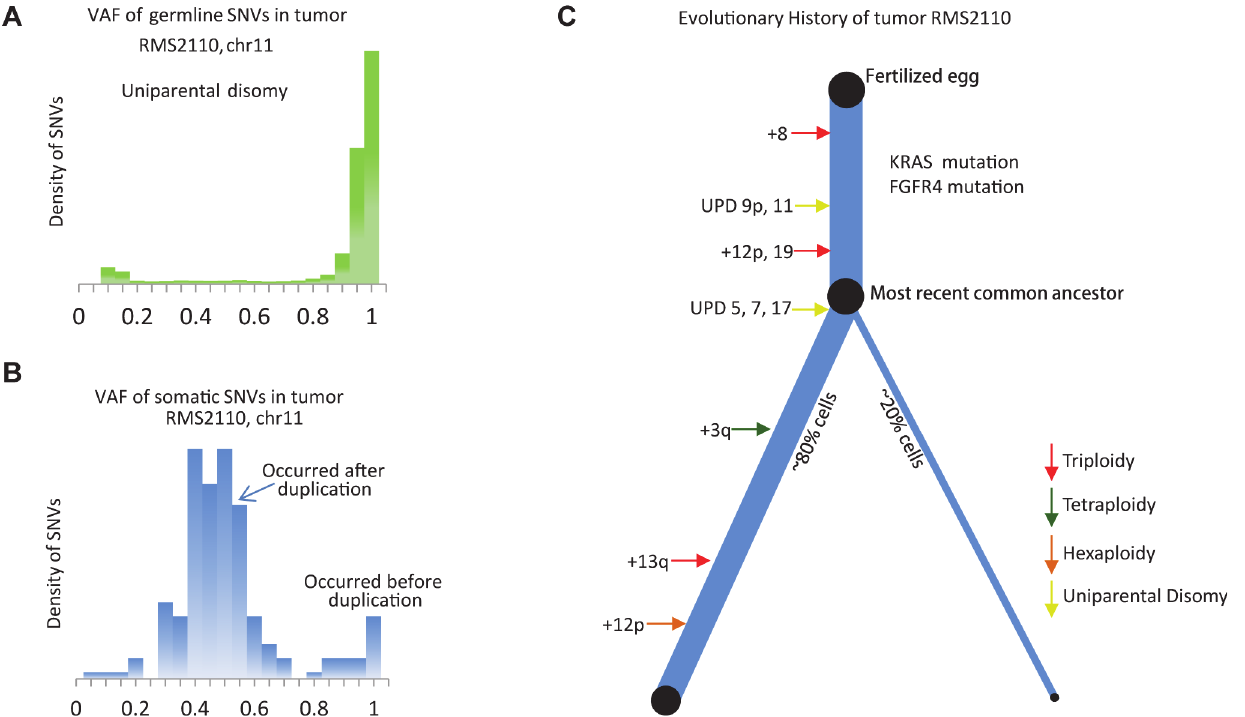
Fig 3. Inferring evolutionary history of a PFN sample, RMS2110. (a) The VAF of germline SNVs on chromosome 11 is distributed around 1, as a result of the uniparental disomy (LOH with duplication). (b) The VAF of somatic mutations is quite different from that of germline SNVs, suggesting majority of somatic mutations happen after the duplication event and thus are present in only one copy of chromosome 11. The earlier occurrence of the duplication of chromosome 11, the more somatic mutations with VAF = 0.5 are detected. S7 Fig. provides a more illustrative explanation. (c) Inferred evolutionary history represented as a phylogenetic tree. The thickness of the branches reflects the proportion of tumor cells in each lineage. The length of the branches reflects how much molecular time it undergoes with each lineage.